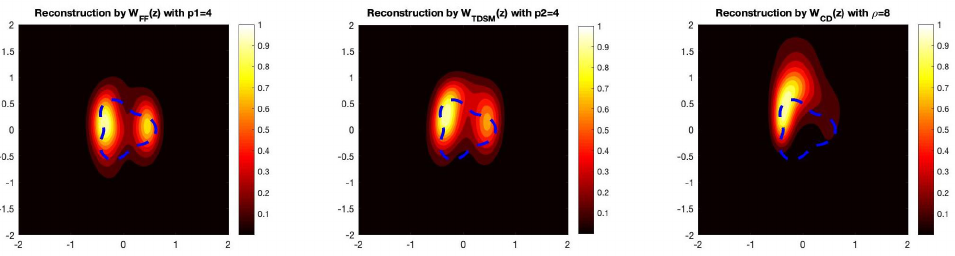
Figure 8. The reconstruction of the acorn-shaped obstacle with 1/2 partial aperture data. In this example, we take δ = 0.05, which corresponds to a 5% noise level.